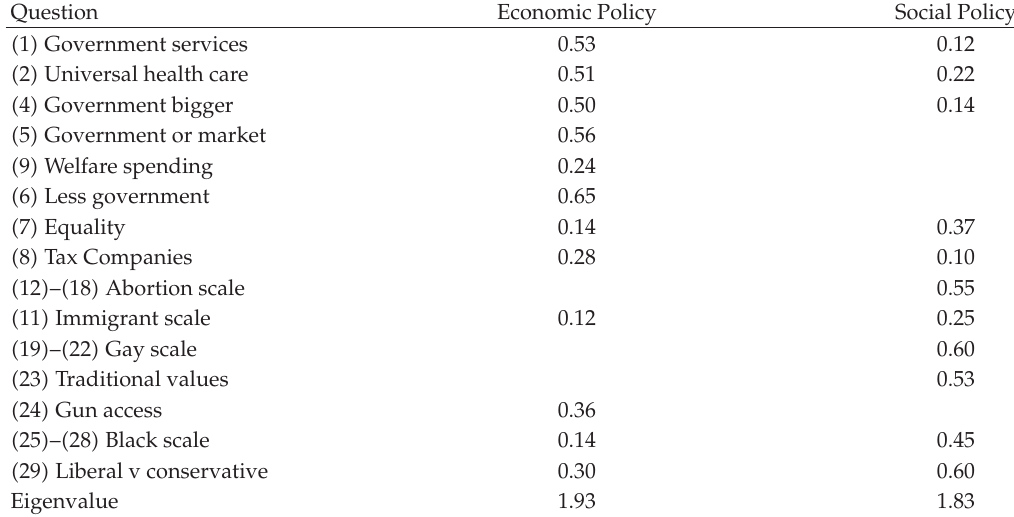
Table 4: Factor loadings for economic and social policy.